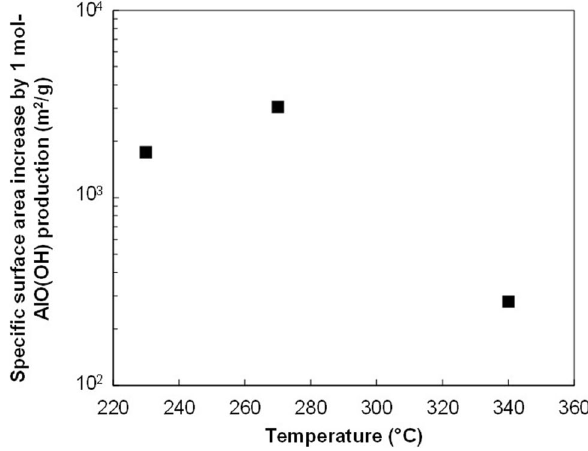
Fig. 10 Increase in specific surface area by 1 mol AlO(OH) produc- tion in relation to